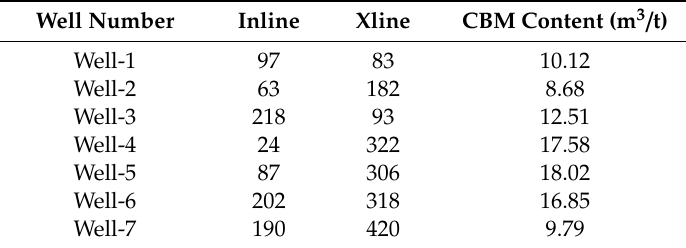
Table 8. CBM drilling information of this exploration area.